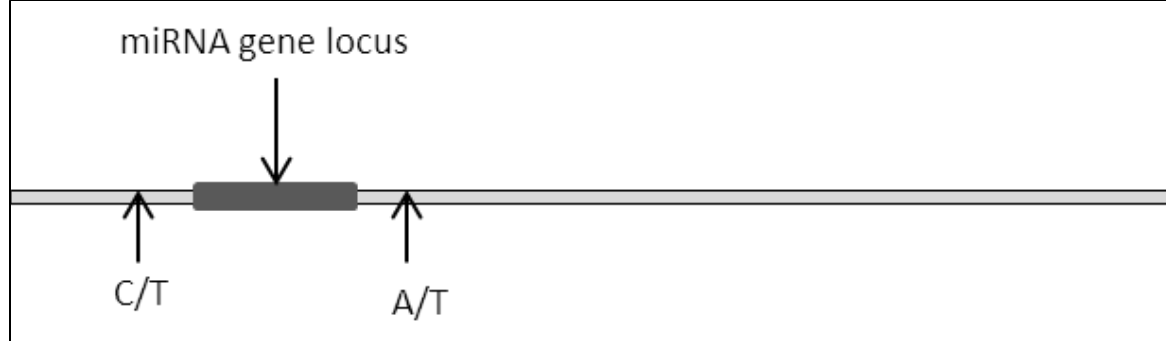
Figure 1. miRNA loci amplification resulted in repeating miRNA sequences thus increasing basal expression of miRNA.